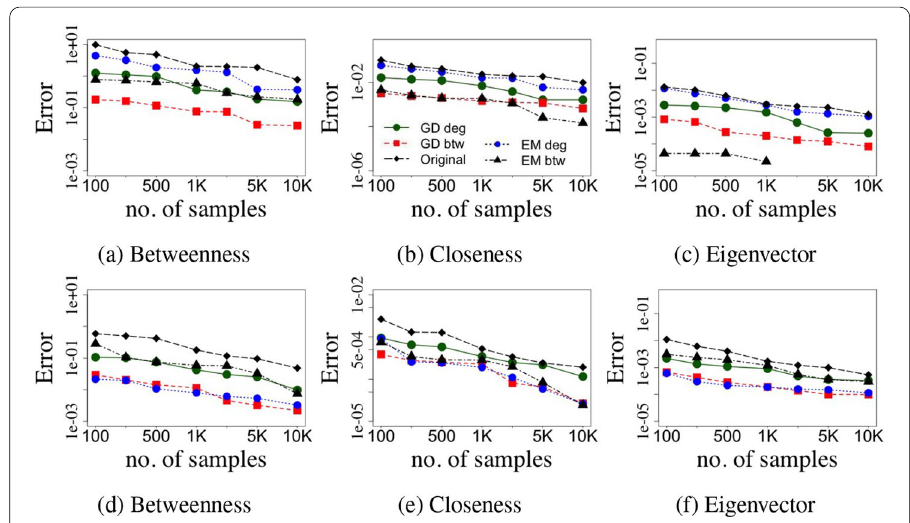
Fig. 8 Required number of samples to calculate measures over sparsified graphs with errors lower than a specific threshold: a – c The original graph is Erdős–Rényi with ρ = 0.1 . The sparsification ratio is α = 0.45 and backboning method the maximum spanning tree method, d – f the original graph is the brain network, sparsification ratio is α = 0.55 and the backboning method is the noise corrected